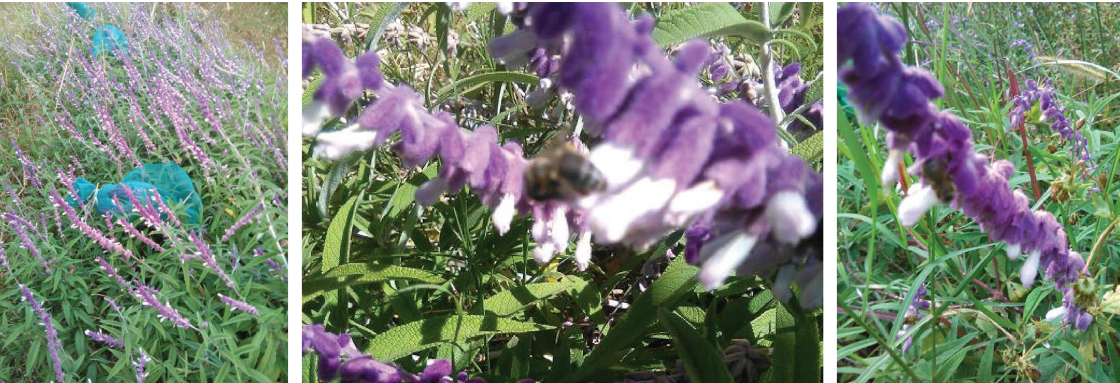
Figure 2: Flowers of S. leucantha and when the honeybees collect nectar.